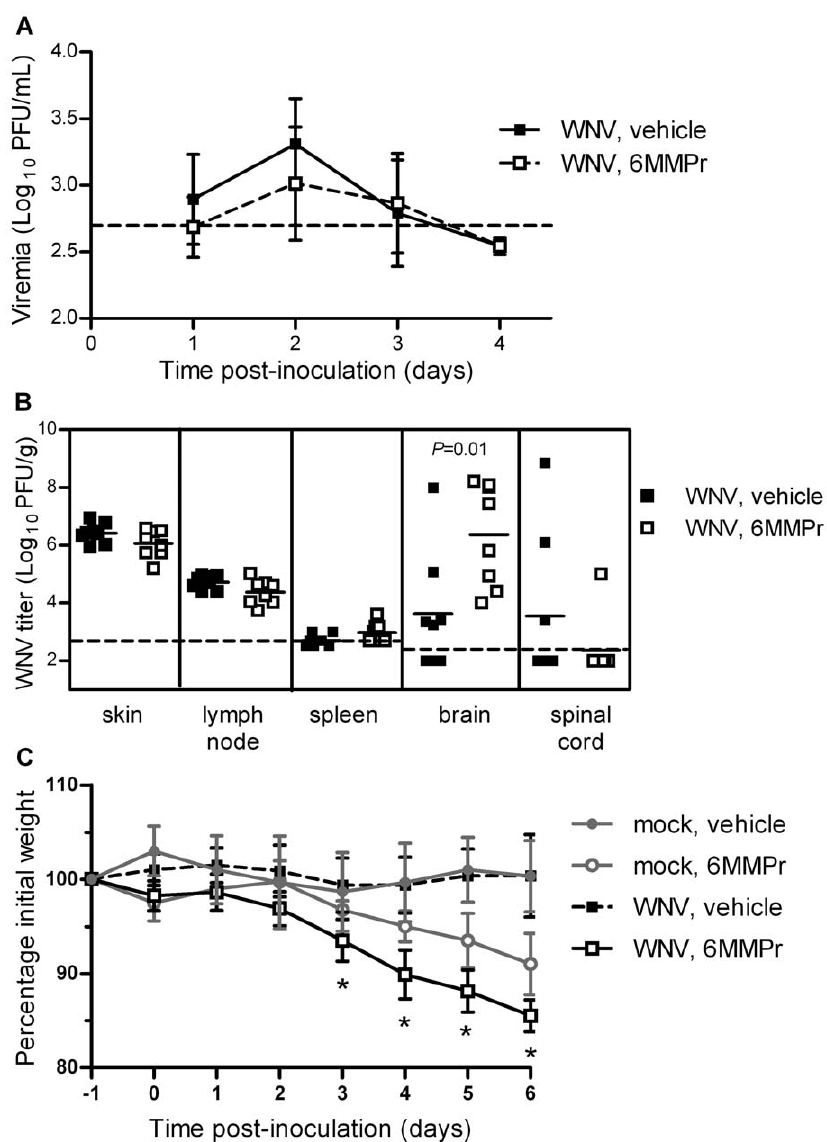
Figure 4. The effect of 6MMPr treatment of mice during WNV infection was tissue dependent. Adult, female C3H mice were pre-treated with vehicle or 6MMPr once daily for seven consecutive days (days 2 1 to 5 pi). On day 0, mice were inoculated SC with diluent alone (mock; n=3–4 per group) or 10 3 PFU of WNV (n=8 per group). Mice were weighed daily, serially bled three times between days 1–4 pi (for WNV-inoculated mice, n=4 per group on days 1 and 4 pi and n=8 per group on days 2 and 3 pi), and euthanized on day 6 pi when tissues were harvested. (A) The geometric means 6 standard deviations of virus titers in sera are shown. (B) Viral loads in tissues on day 6 pi are shown. Each data point represents an individual mouse, and the horizontal solid lines represent the geometric means. (C) The means 6 standard deviations of the percentage initial weight are shown, and significant P values between mock-inoculated, 6MMPr-treated mice and WNV-inoculated, 6MMPr-treated mice are indicated: *, P , 0.05. For (A) and (B), significant P values between vehicle and 6MMPr treated mice inoculated with WNV are noted on the graphs, and the dashed lines represent limits of detection of (A) 500 PFU/mL or (B) 500 PFU/g for skin, draining lymph nodes and spleen and 250 PFU/g for brain and spinal cord. Data points below the dashed lines are less than the limit of detection for the plaque